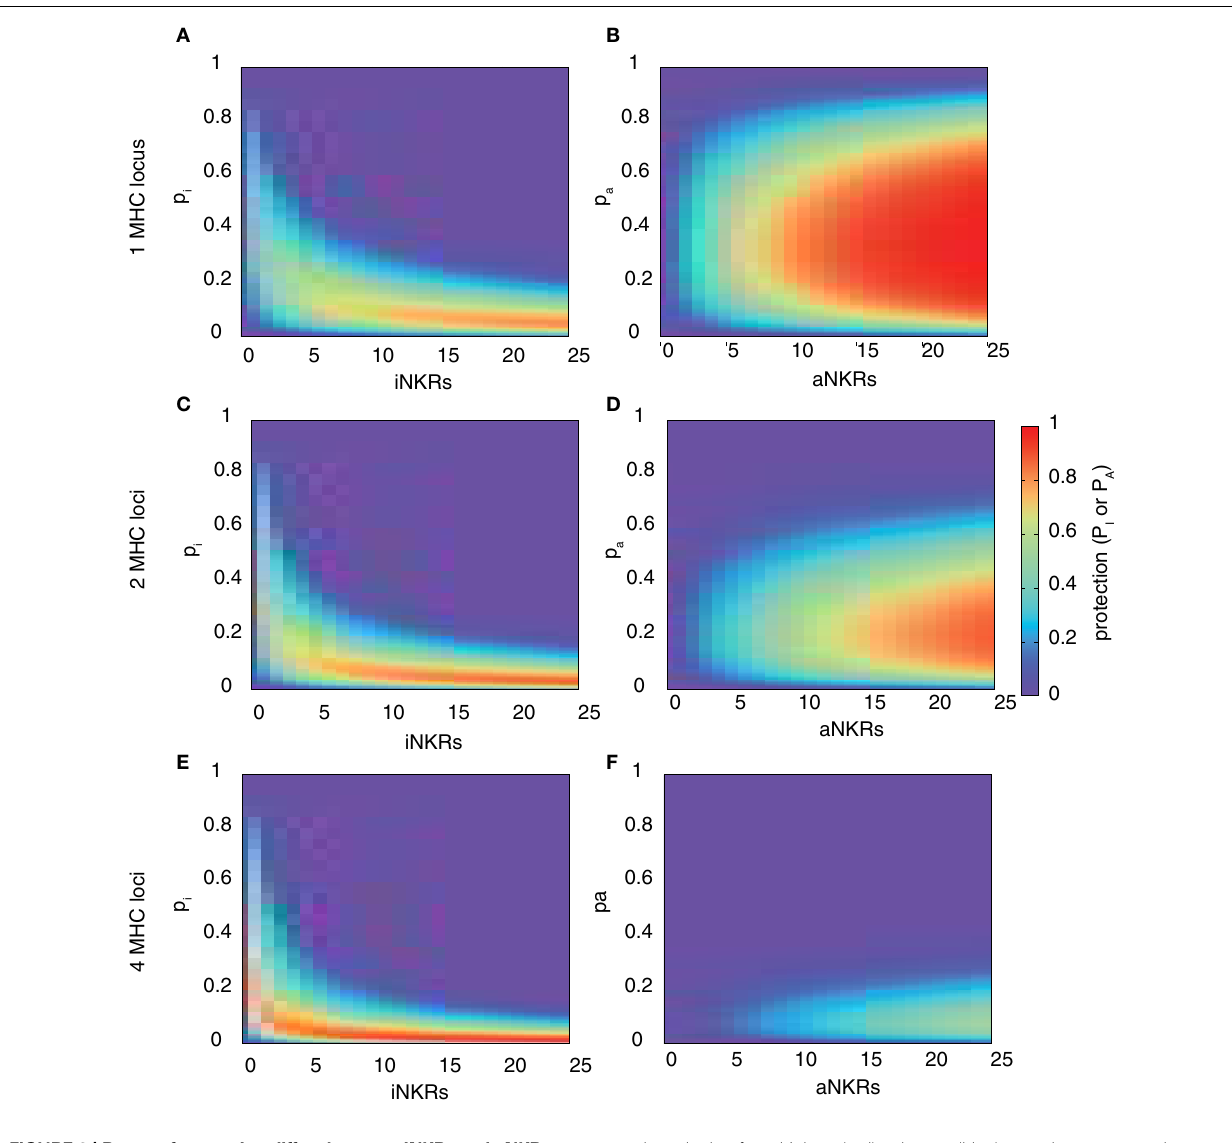
the color bar from highest (red) to lowest (blue). p i and p a correspond to the specificity of iNKR and aNKR, respectively. (A,B) The protective range for iNKRs is small and skewed toward a large haplotype size and high specific values. In contrast, aNKRs offer a broad range of protection for intermediate specificity values and a smaller haplotype size. Calculations were done with 1 MHC locus (A,B) , 2 MHC loci (C,D) , and 4 MHC loci (E,F)